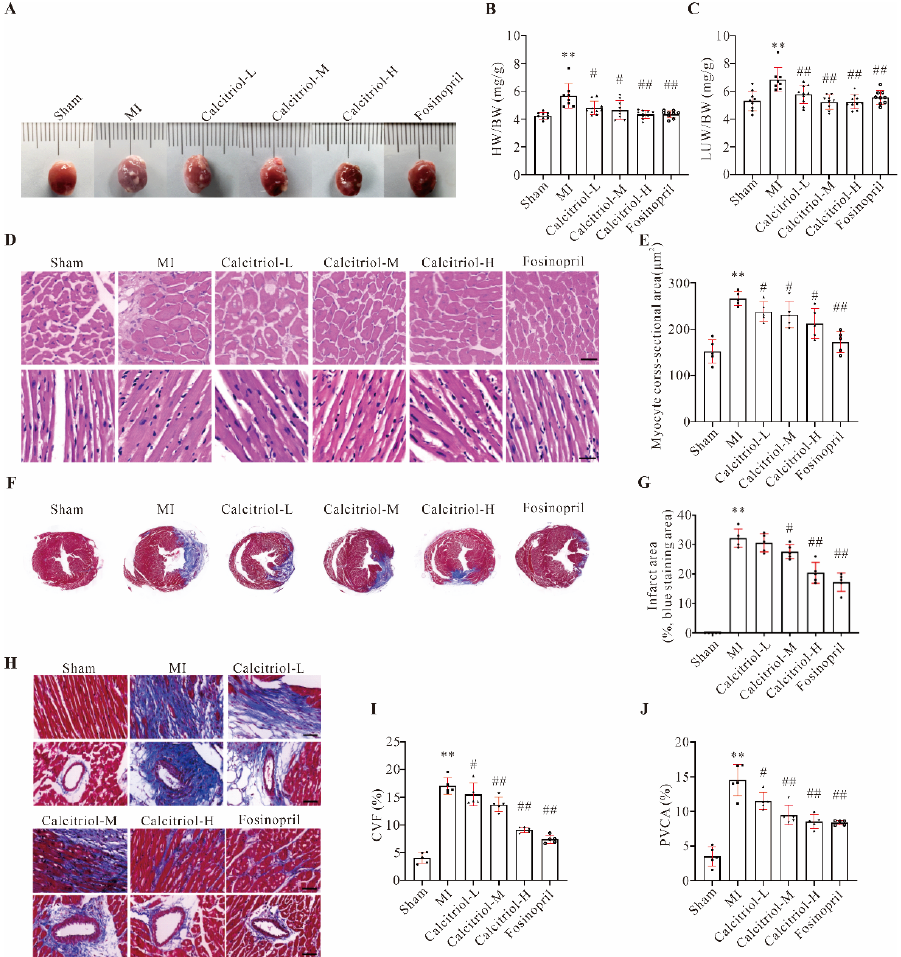
Figure 2. Calcitriol reversed MI-induced adverse cardiac remodeling. ( A ) Representative macroscopic heart images. ( B , C ) Ratios of heart (HW, B ) or lung (LUW, C ) weight to body weight (BW) (mg/g) ( n ≥ 8). ( D , E ) H&E staining analysis of the cross-sections of the middle part of murine hearts. Representative images ( D ) and quantitative analysis of myocyte cross-sectional area (CSA, E ) from five mice ( n = 5 mice for each group) were presented here. Scale bar represents 50 μm. ( F , G ) Masson- trichrome staining analysis of the cross-sections of the middle part of murine hearts. Representative images ( F ) and quantitative analysis of infarct area (%, blue staining area, G ) from five mice ( n = 5 for each group) were presented here. ( H – J ) Cardiac fibrosis analysis of the cross-sections of the middle part of murine hearts. Representative images of myocardial and perivascular fibrosis ( H ), and quantitative analysis of collagen volume fraction (CVF, %, I ) and perivascular collagen area (PVCA, %, J ) from five mice were presented here ( n = 5 mice for each group). Three images from each mouse were measured and averaged in quantitative analysis. (Scale bar represents 50 μm. Data represent means ± S.D. ** p < 0.01 versus sham group, # p < 0.05, ## p < 0.01 versus MI group; one-way ANOVA with a post hoc test of Tukey’s analysis).